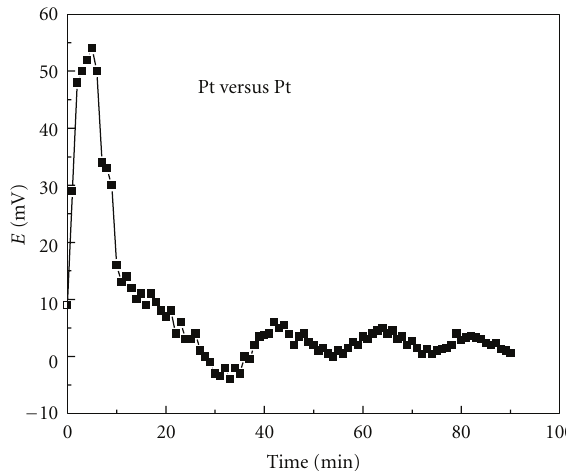
Figure 2: Potential fluctuations of a platinum reference electrode versus another platinum reference